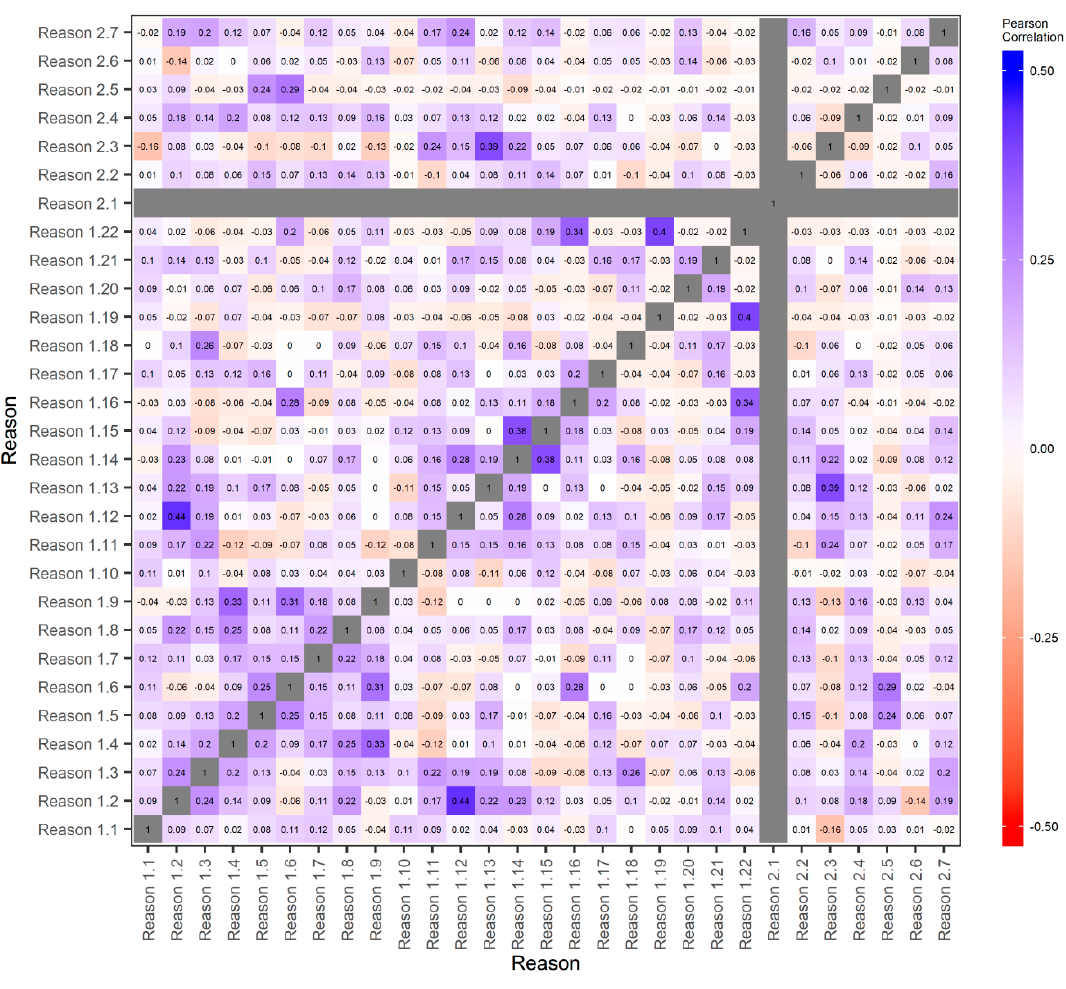
Figure 10. Correlation matrix between the indicator (i.e., 0–1) series obtained for each reason (see Sections 2.8.1 and 2.8.2) based on the list of reviewed articles.